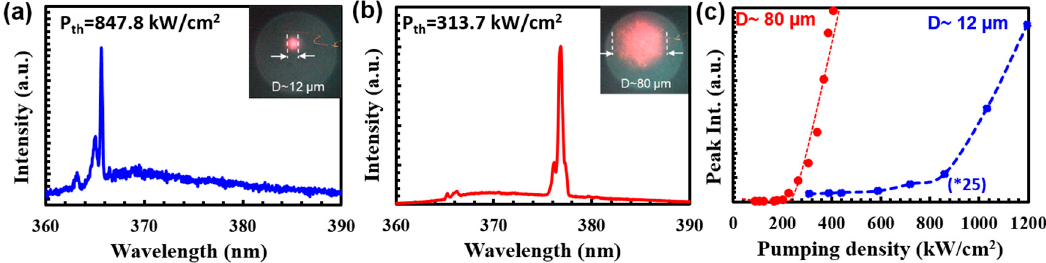
Figure 2. The lasing spectrum under 1.5 times of the threshold pumping density (P th ), where the diameter of the laser spot was ( a ) 12 µ m and ( b ) 80 µ m. The P th value and optical microscopic image are the insets. ( c ) The light–light curves with D ~ 12 µ m (blue) and D ~ 80 µ m (red). The intensity under small spot excitation was multiplied 25 times intentionally for figure clarity.